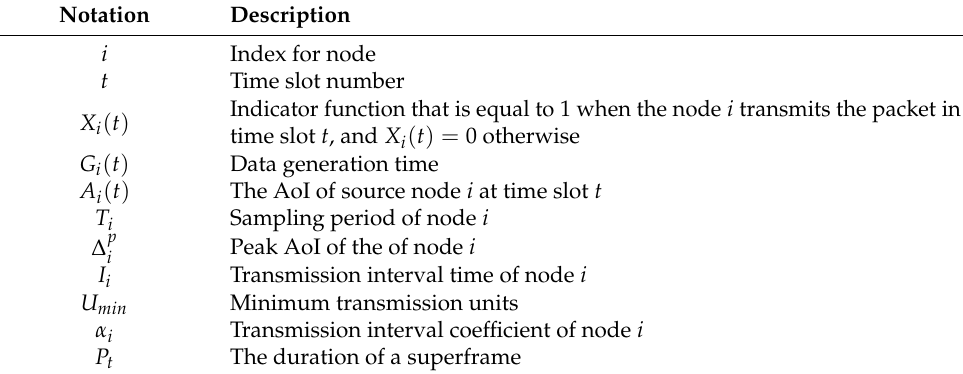
Table 1. List of key